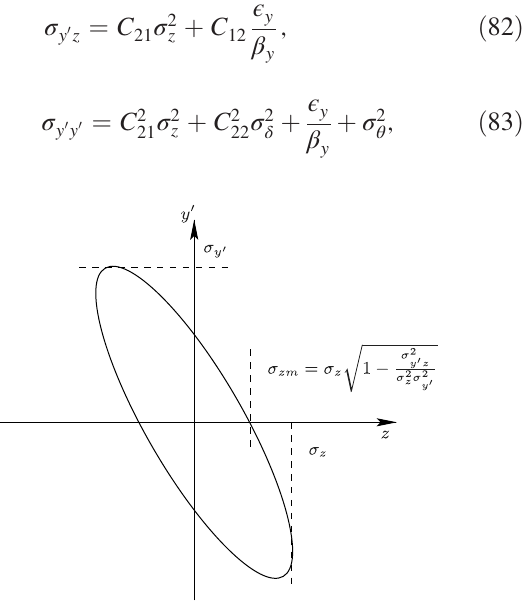
FIG. 1. The projected y 0 - z